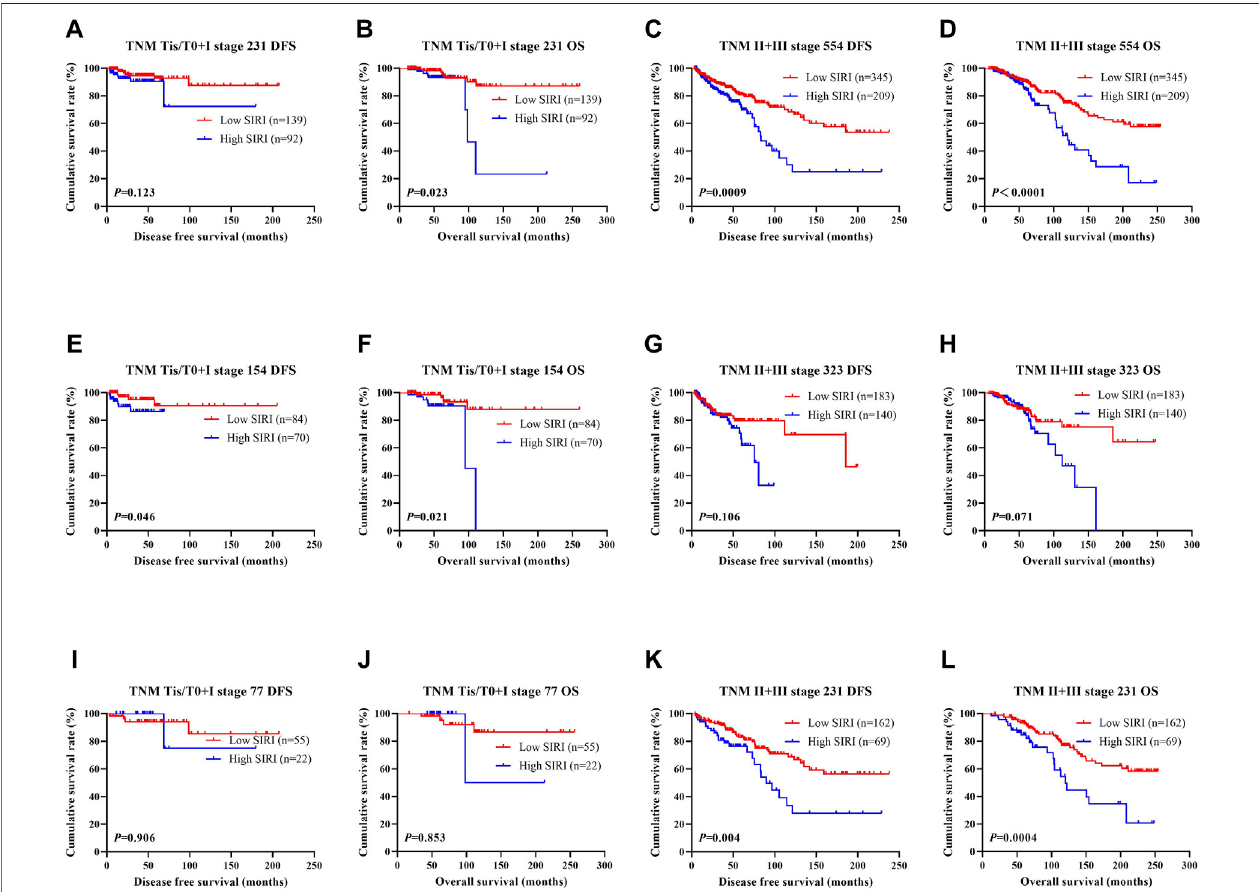
FIGURE 2 | DFSandOSbasedonSIRIscoresofpatientswithbreastcancerofdifferentpathologicalstage. (A) Kaplan-MeieranalysisofDFSfortheSIRIofpatientswithearlybreastcancer. (B) Kaplan-MeieranalysisofOSfortheSIRIofpatients withearly breastcancer. (C) Kaplan-Meieranalysis ofDFS for the SIRIofpatientswithadvanced breast cancer. (D) Kaplan-Meieranalysis ofOSfor the SIRIofpatientswith advancedbreastcancer. (E) Kaplan-MeieranalysisofDFSfortheSIRIofpatientswithearlybreastcancer(NACTgroup). (F) Kaplan-MeieranalysisofOSfortheSIRIof patients with early breast cancer (NACT group). (G) Kaplan-Meier analysis of DFS for the SIRI of patients with advanced breast cancer (NACT group). (H) Kaplan-Meier analysisofOSfortheSIRIofpatientswithadvancedbreastcancer(NACTgroup). (I) Kaplan-MeieranalysisofDFSfortheSIRIofpatientswithearlybreastcancer(non-NACT group). (J) Kaplan-Meier analysis of OS for the SIRI of patients with early breast cancer (non-NACT group). (K) Kaplan-Meier analysis of DFS for the SIRI of patients with advanced breast cancer (non-NACT group). (L) Kaplan-Meier analysis of OS for the SIRI of patients with advanced breast cancer (non-NACT